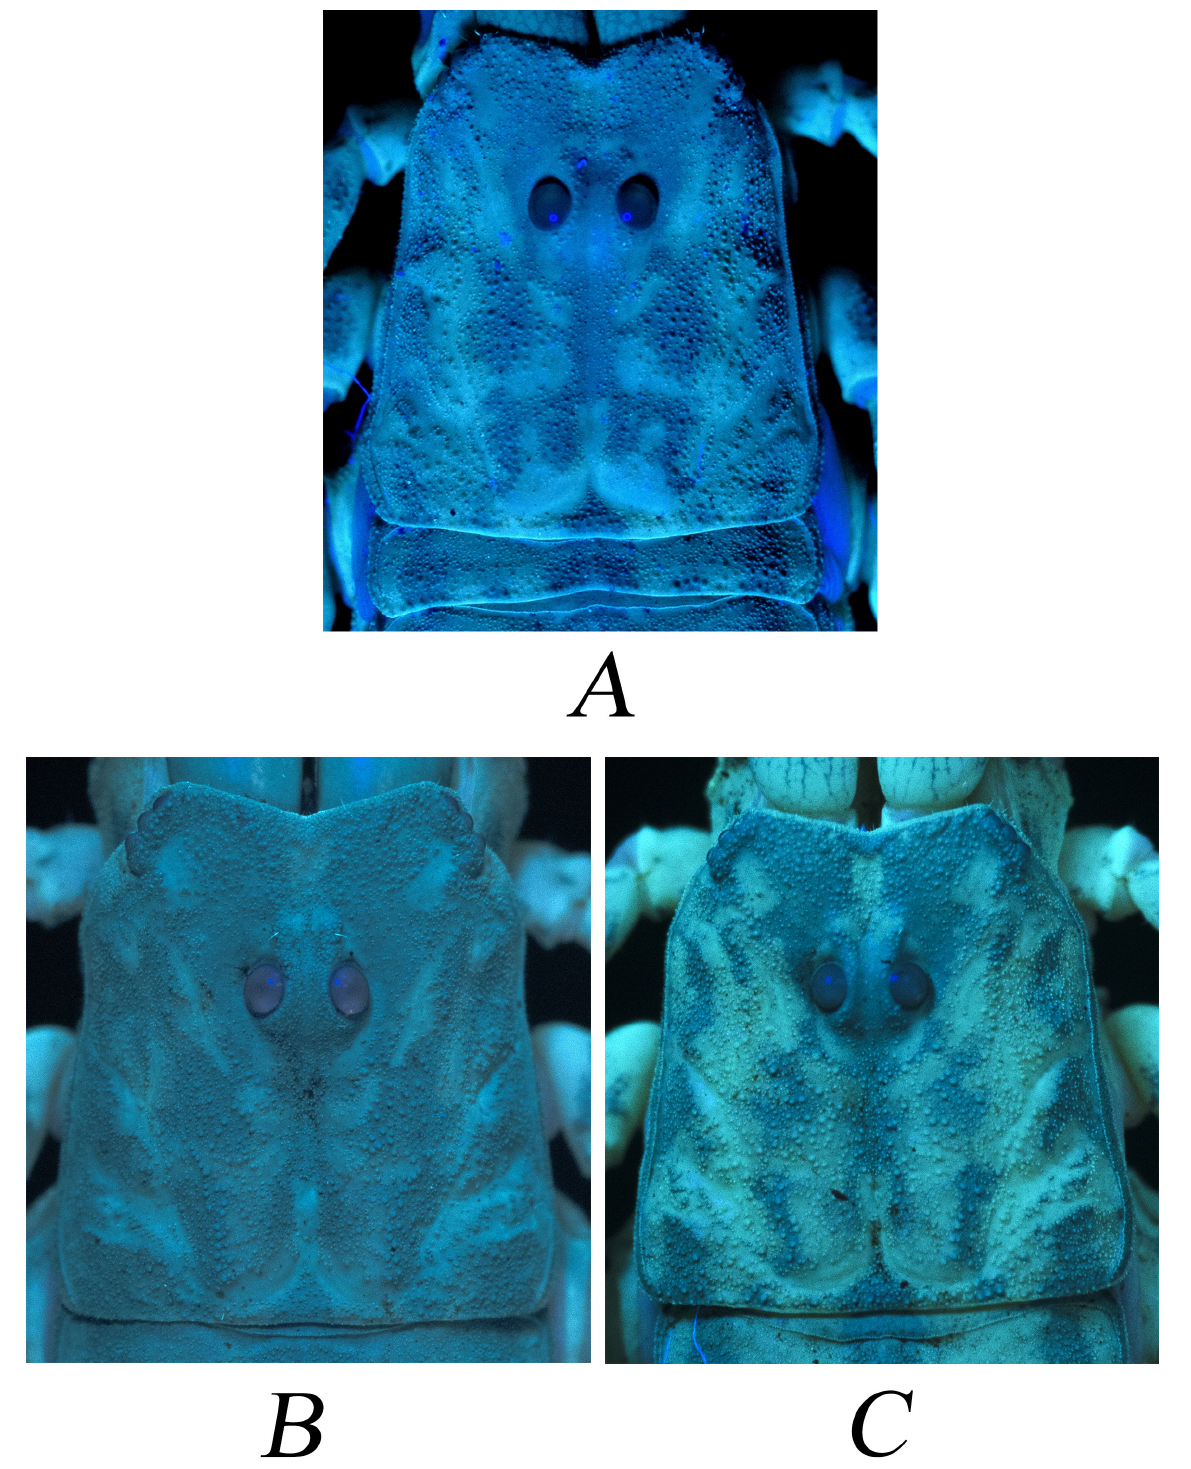
Fig. 18. Carapace under UV light. A . Isometrus sankeriensis Tikader & Bastawade, 1983, neotype, adult ♂ (BNHS SC 194). B . I. nakshatra sp. nov., holotype, adult ♂ (BNHS SC 195). C . I. wayanadensis sp. nov., holotype, adult ♂ (BNHS SC